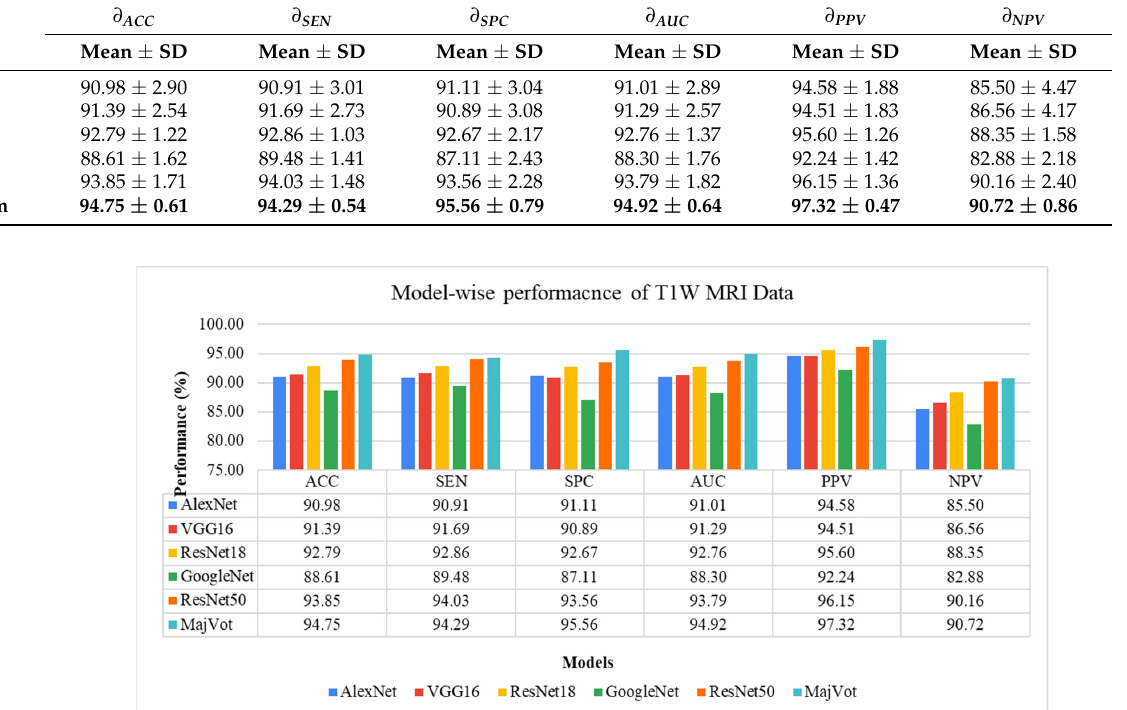
Table 6. Five-fold test performance of T1W-MRI Data.